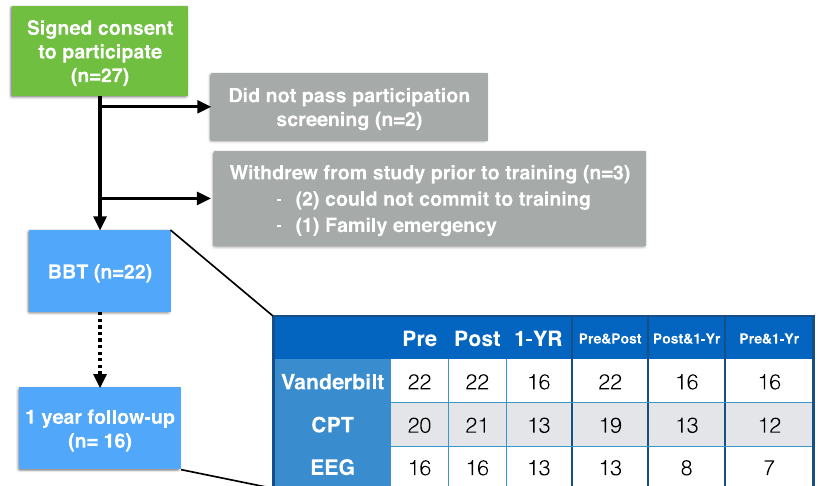
Fig. 2 CONSORT diagram. Illustration depicting the number of participants at different stages of the study, from consent to enrollment and 1-year follow-up. The embedded table re fl ects the number of participants with datasets for each of the primary measures of interest at each time point, as well as the number of individuals with data at each paired timepoint. For the CPT task, missing data was due to participants not being able to stay to the end of their testing session due to other outside obligations those days. For the EEG recordings, missing data points re fl ect a hardware error where photodiodes used to time lock the onset of targets were not functioning properly, preventing the analysis of event-related